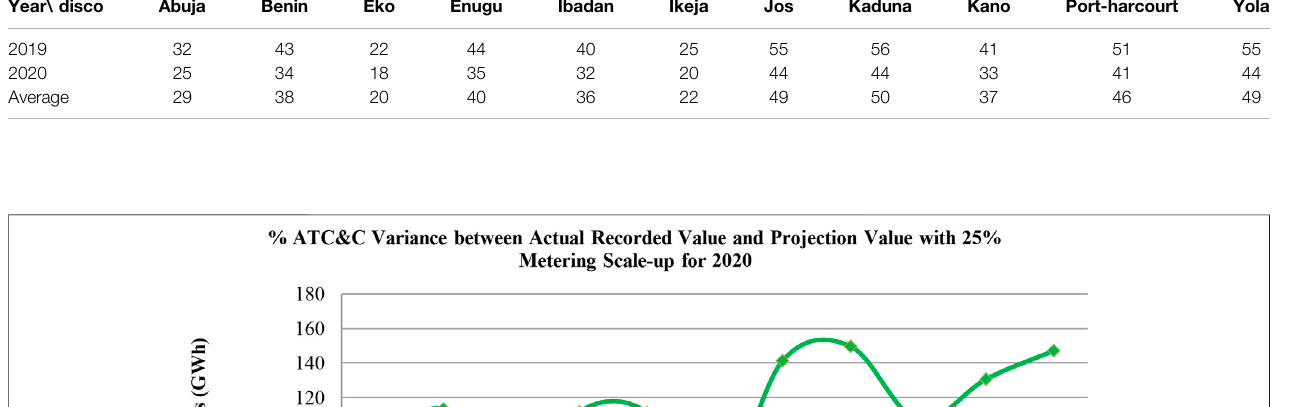
TABLE 8 | Summary of 2019 – 2020 projection of % ATC&C losses due to 25% metering scale-up (GWh). Year\ disco Abuja